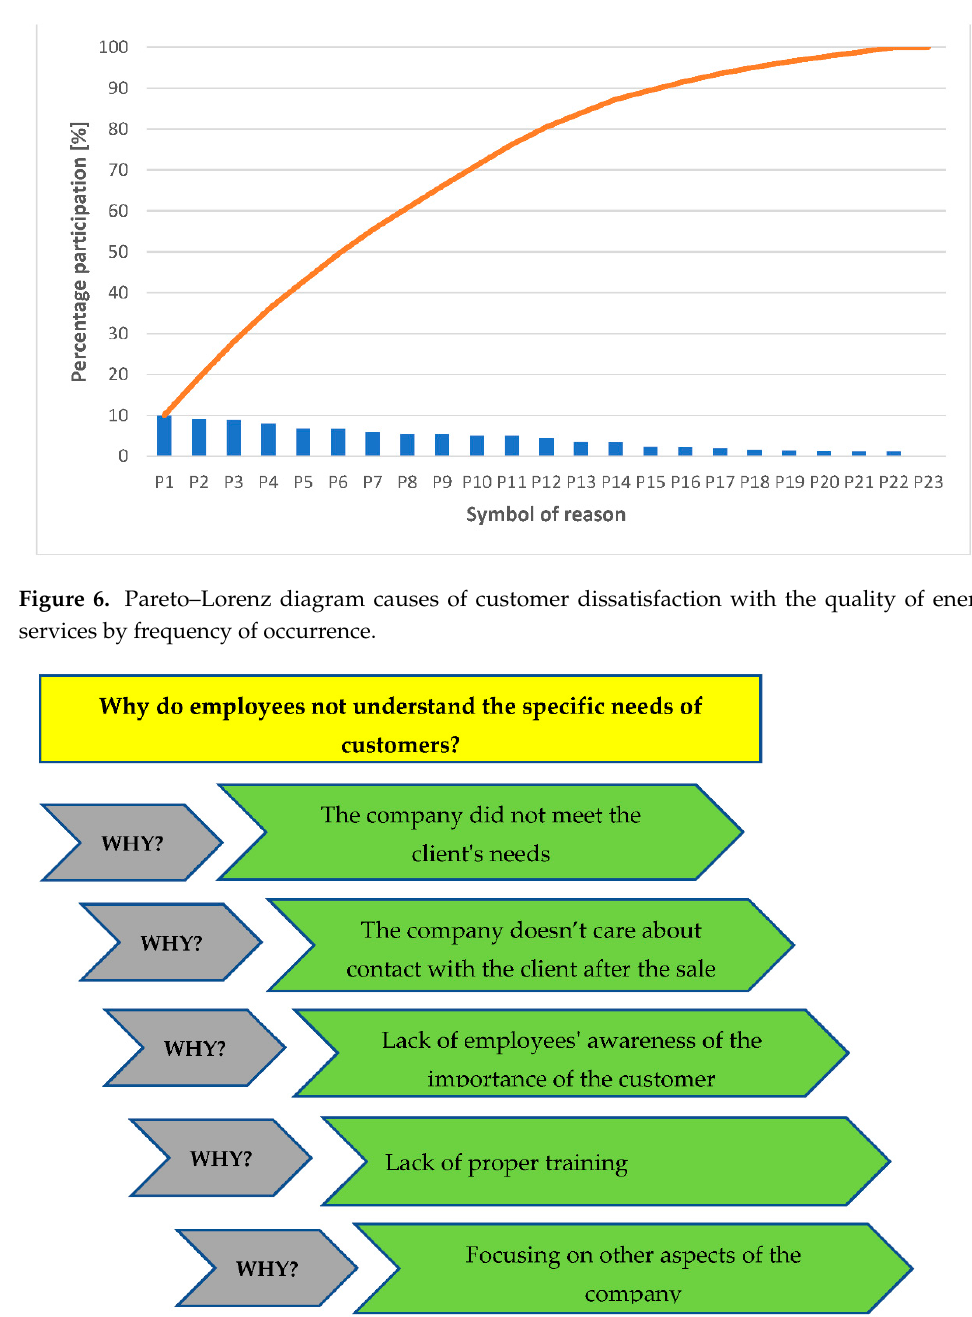
Figure 7. The 5 WHY method for the problem: Why do employees not understand the specific needs of customers?